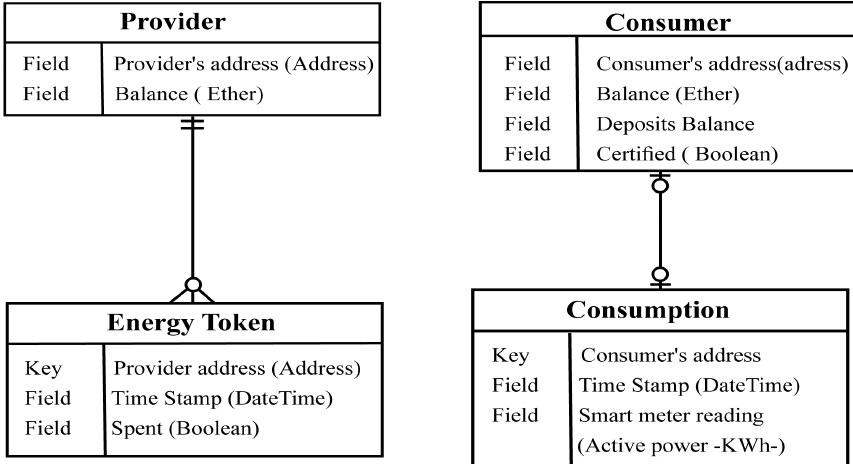
Figure 7. ERD diagram of the proposed